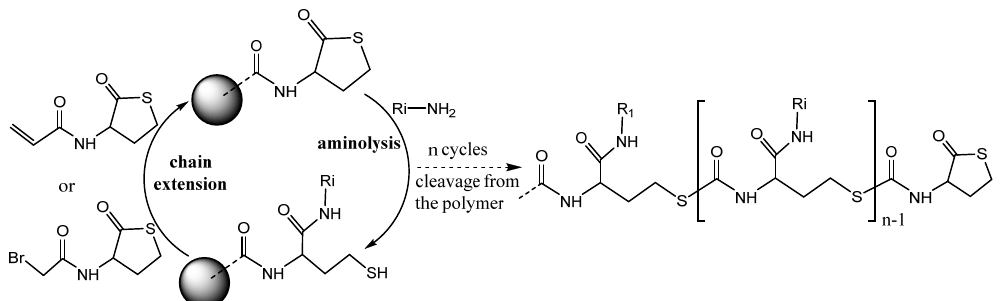
Figure 7. Two-step protocol for the functional polymer solid-state synthesis using HTL derivative building block ap- proach.